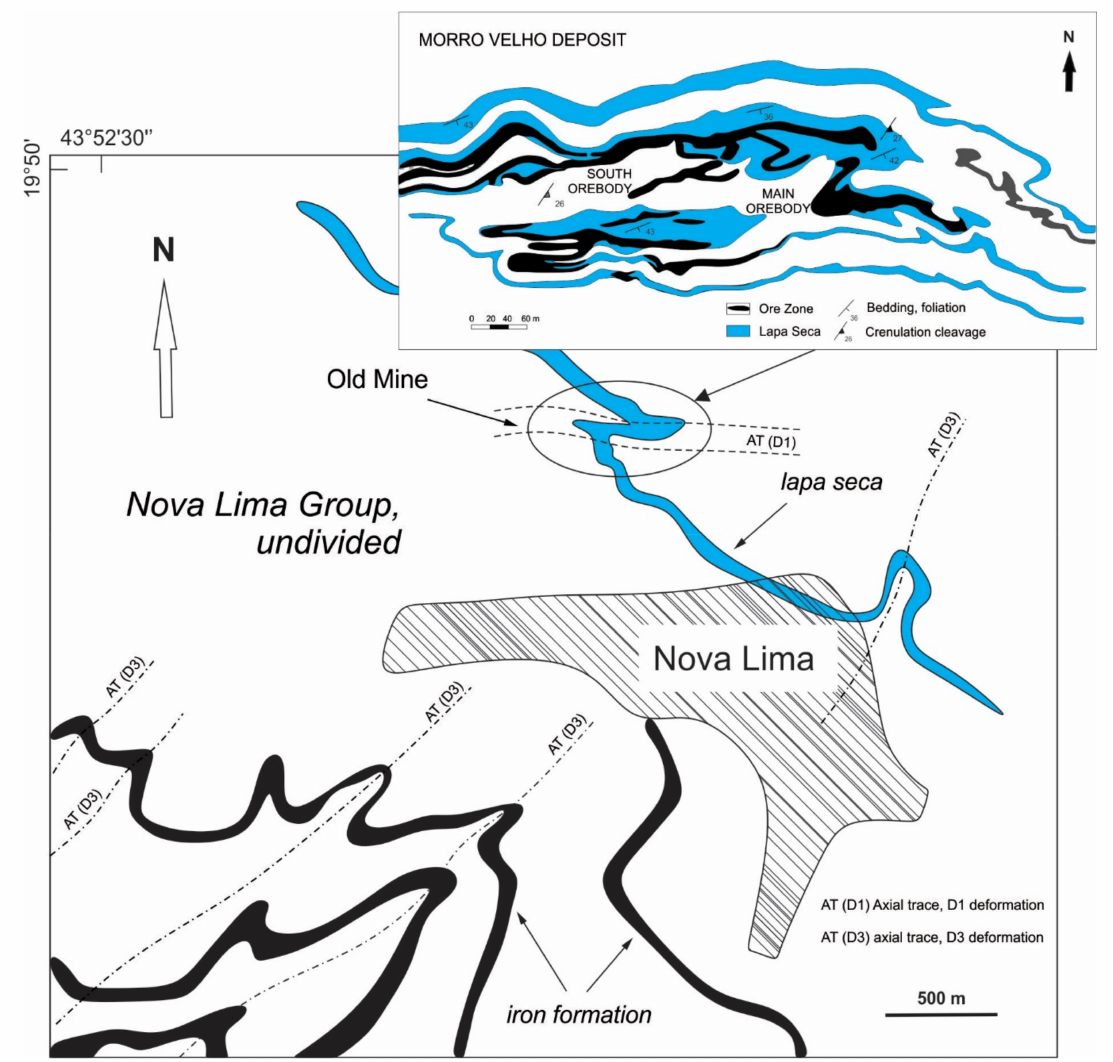
Figure 7. The Archean Z-shaped fold of the lapa seca and the Morro Velho gold deposit. The lower left corner shows Transamazonian D3 folds that a ff ect banded iron formations (BIF). Clipping of the geological map of the Nova Lima quadrangle [123]. Insert shows the Morro Velho gold deposit